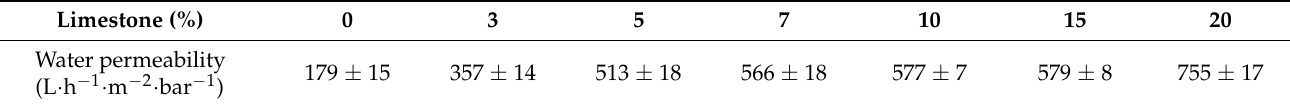
Table 5. Membrane water